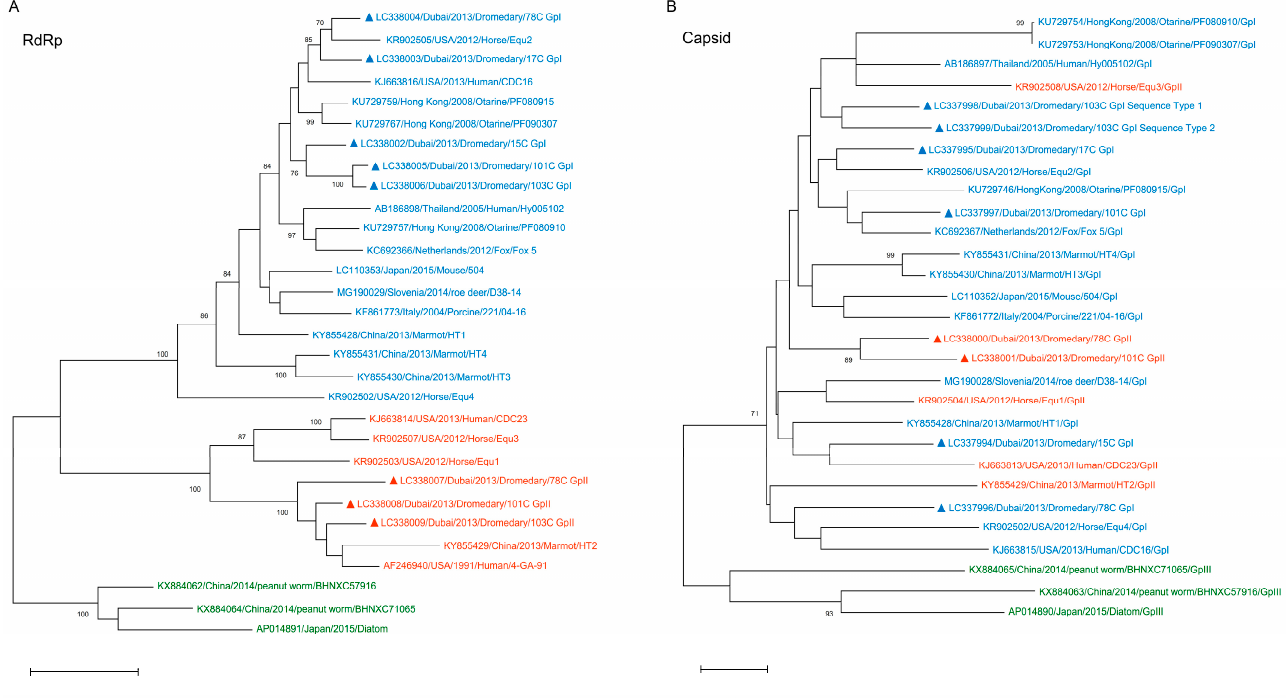
Figure 3. Phylogenetic analysis of ( A ) the RdRp and ( B ) the capsid protein of genogroup I and II PBVs detected in dromedary fecal samples and their relationship with other corresponding protein sequences of genogroup I, II, and III PBVs. The tree was constructed using the maximum likelihood method and is based on the amino acid of a 205 aa RdRp fragment of segment 2 and 166 aa capsid protein fragment of segment 1. Numbers at nodes indicated level of bootstrap support calculated from 1000 replicates; bootstrap values below 70% are not shown, and the scale bar indicates the number of amino acid substitutions per site. Sequences of dromedary samples included in the present study are indicated by a triangle. Blue, genogroup I; red, genogroup II; green, genogroup III.